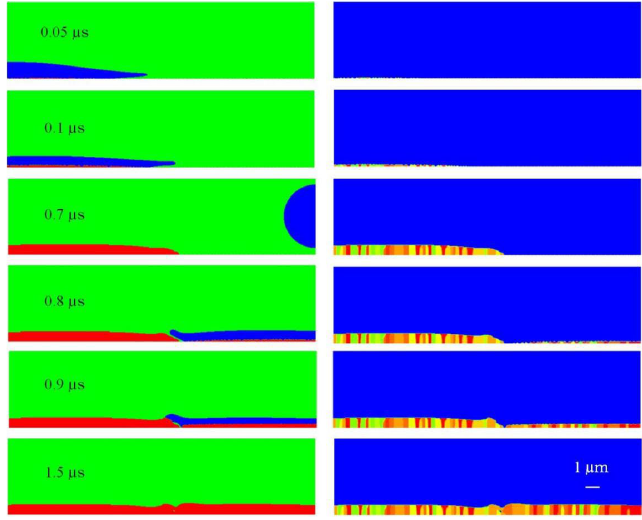
Figure 14. Sequential droplet impact with well bonding.